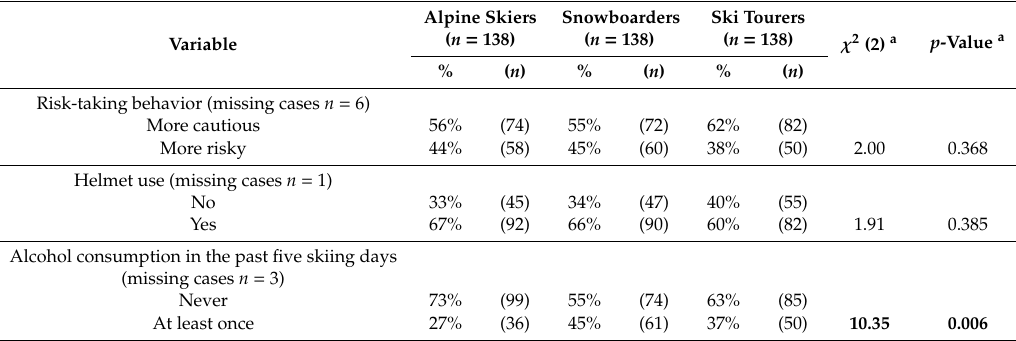
χ 2 (2) a p -Value a ( n = 138) ( n = 138) ( n = 138)